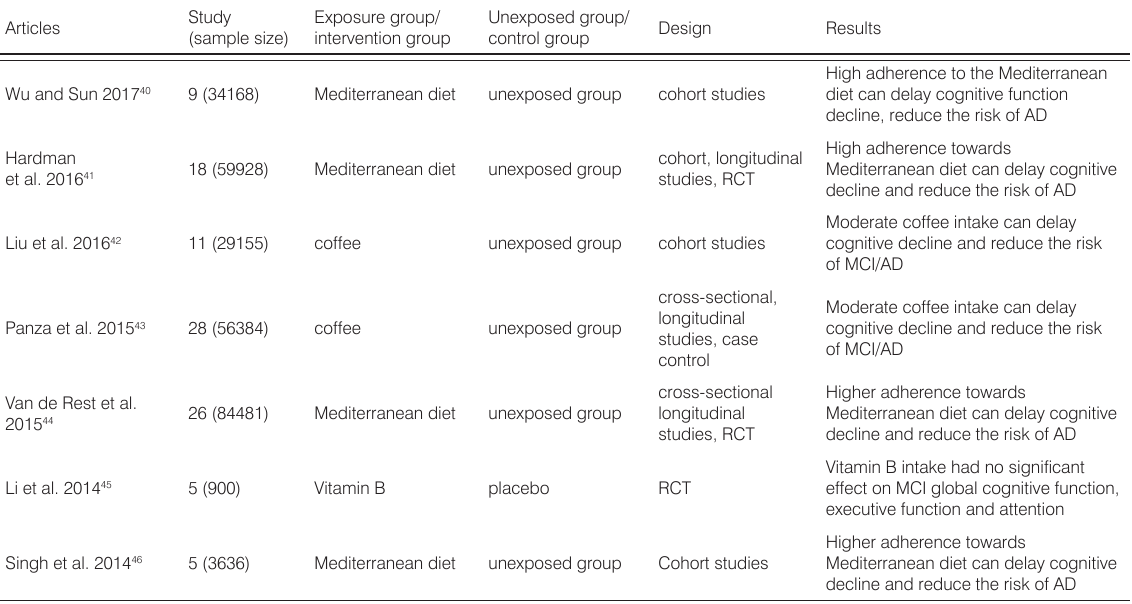
Table 8. A summary of the characteristics of systematic reviews (SRs) analyzing dietary interventions and detailed characteristics obtained from the full data